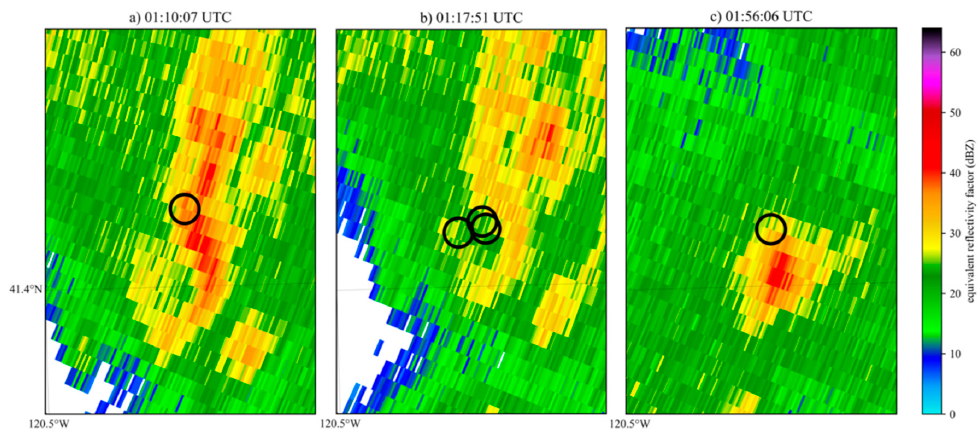
Figure 7. Base reflectivity (dBZ) from the WSR-88D radar in Medford, OR showing FS stroke locations (circles) near the times of their discharge at a ) 0110 UTC b ) 0117 UTC and c ) 0156 UTC 25 July 2017 [45].